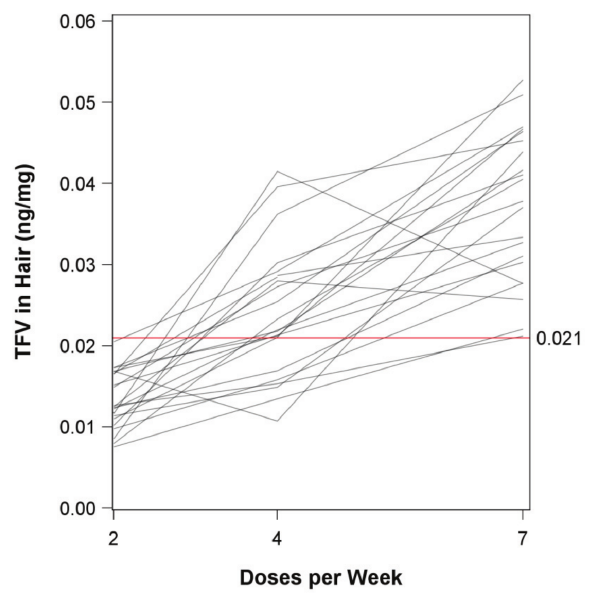
Figure 3. Spaghetti plot of tenofovir (TFV) concentrations. Hair TFV concentrations for each subject are shown for each dosing period. Each line represents drug concentration data from one participant (at 2, 4, and 7 doses/week). The red line distinguishes between hair scalp concentrations for 2 vs. 7 doses/week. ng/mg=nanogram/milligram. doi:10.1371/journal.pone.0083736.g003 PLOS ONE |